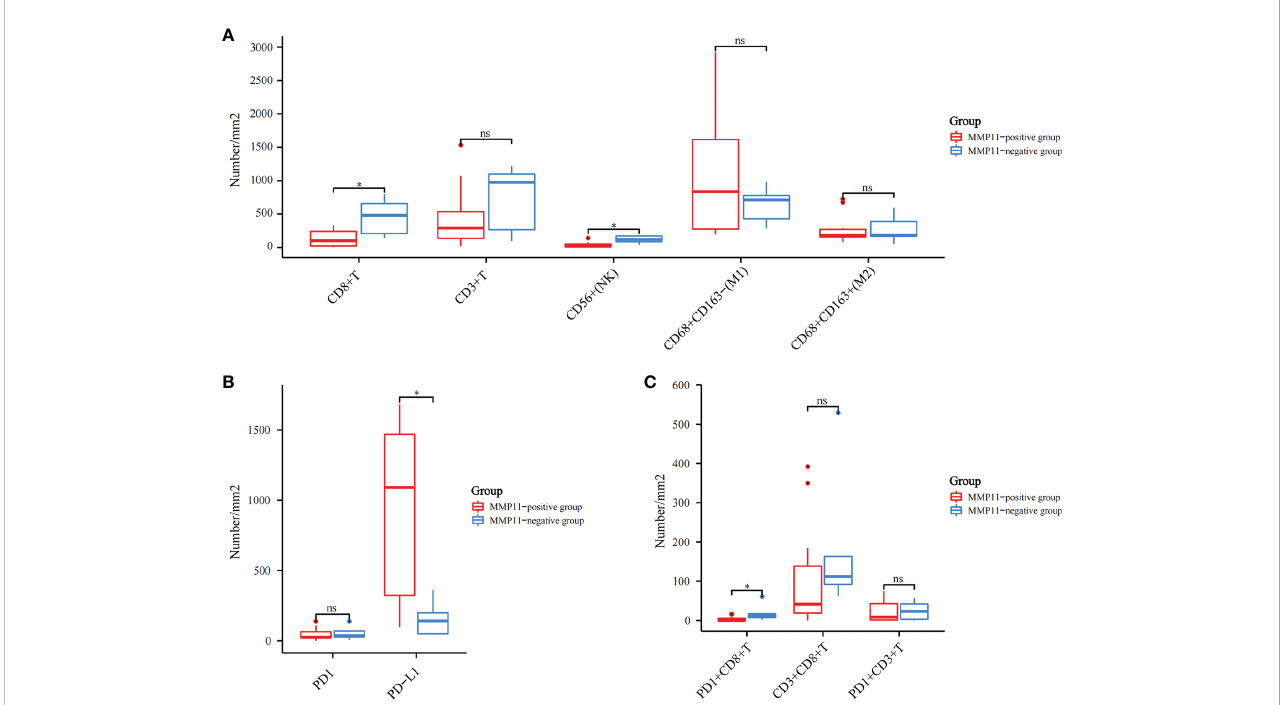
FIGURE 7 Different in fi ltration of immune cells in the tumor parenchyma of 17 EGFR-mutant LUAD cases. Red is the MMP11 positive expression group; blue is the MMP11 negative expression group; (A) Immune cell in fi ltration: CD3+ T cells, CD8+ T cells, NK cells, macrophages M1, macrophages M2; (B) The in fi ltration of different T-cell subtypes: PD1+CD8+ T cells, CD3+CD8+ T cells, PD1+CD3+ T cells; (C) The in fi ltration of CD3+CD8+ T cells and PD1+CD3+ T cells; *P < 0.05; ns, no statistical signi fi